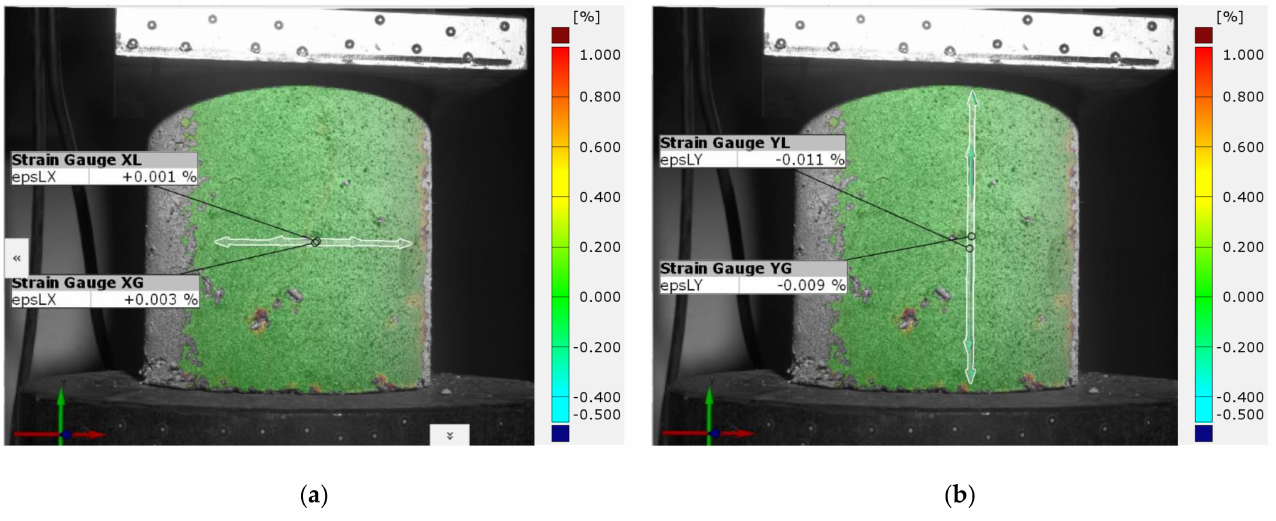
Figure 14. The arrangement of global and local strain gauges ( a ) for lateral measurements, ( b ) for axial